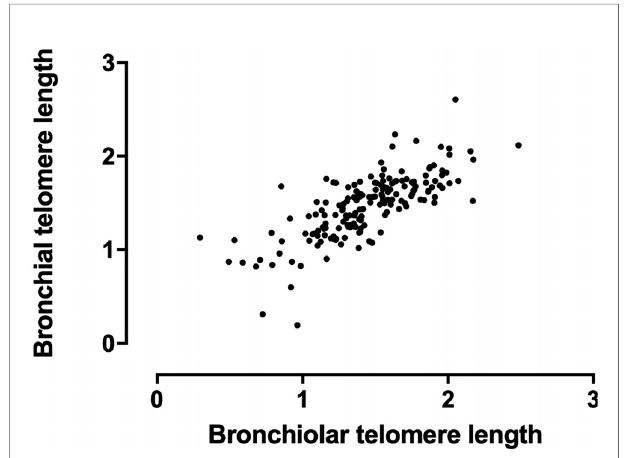
FIGURE 1 | Correlation of bronchial and bronchiolar airway telomere length. Bronchiolar and bronchial airway telomere length are presented as a relative T/S ratio (arbitrary